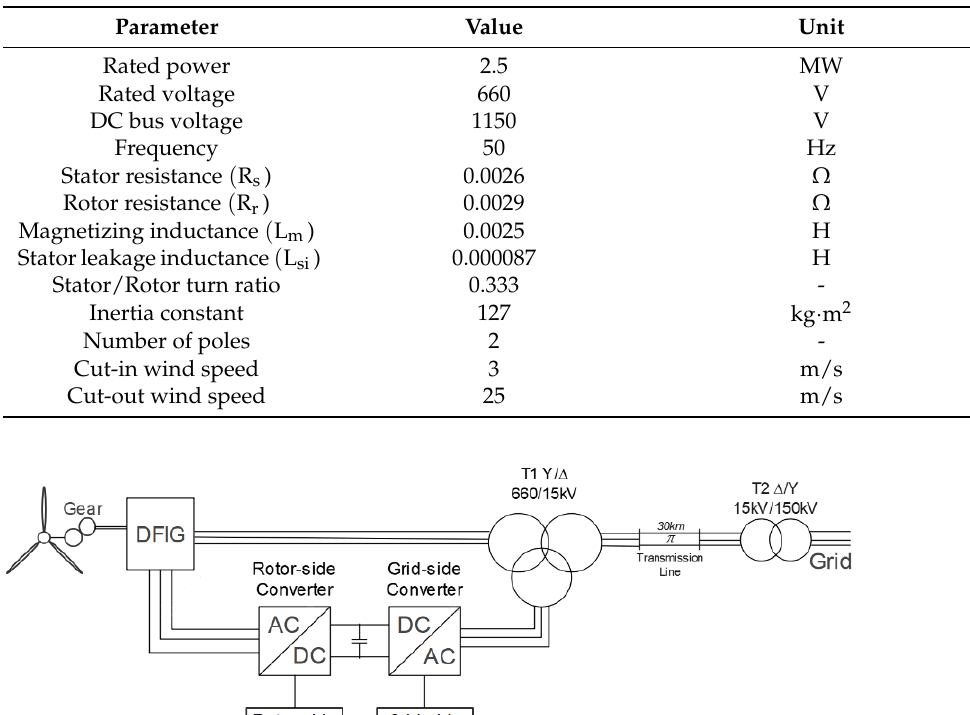
Table 1. DFIG parameters.